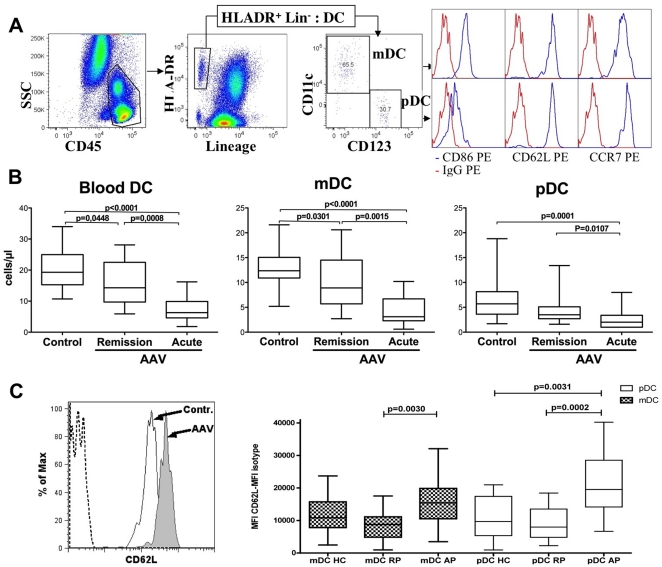
Characterization and count of dendritic cells using flow cytometry.
A, Gating strategy for identification of DC subsets, and expression of CD86, CD62L and CCR7 (blue line) vs. isotype control (red line) on DC subset. B, Quantification of DC, myeloid DC and plasmacytoid DC using flow cytometry is shown for healthy controls (HC ; n = 18), remission phase (RP ; n = 15) and acute phase (AP ; n = 19) AAV patients. Data are presented as boxplots with whiskers from minimum to maximum. C, Left: the histogram shows an exemple of CD62 staining on pDC from a control subject (empty histogram) and an AAV patient in acute phase (grey histogram) as compared to isotype control (dotted line); Right: CD62L expression on pDC and mDC is shown as MFI of CDL62 – MFI of isotype control. Data are presented as boxplots with whiskers from minimum to maximum.